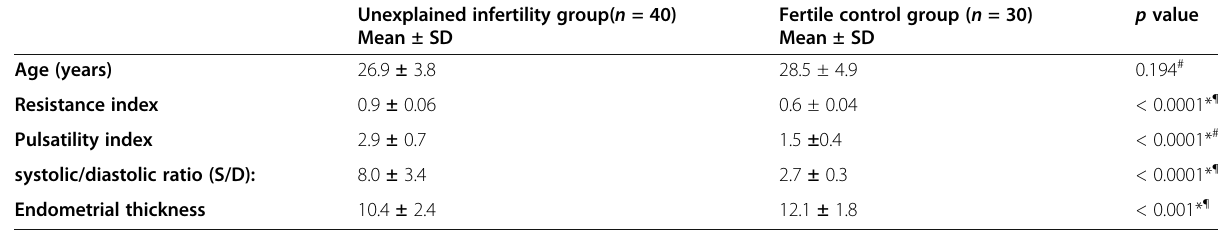
Table 1 Comparison between the unexplained infertility group and the fertile control group according to the mean values of age, uterine arteries resistance index, pulsatility index, systolic/diastolic ratios, and endometrial thickness Unexplained infertility group( n = 40) Mean ±